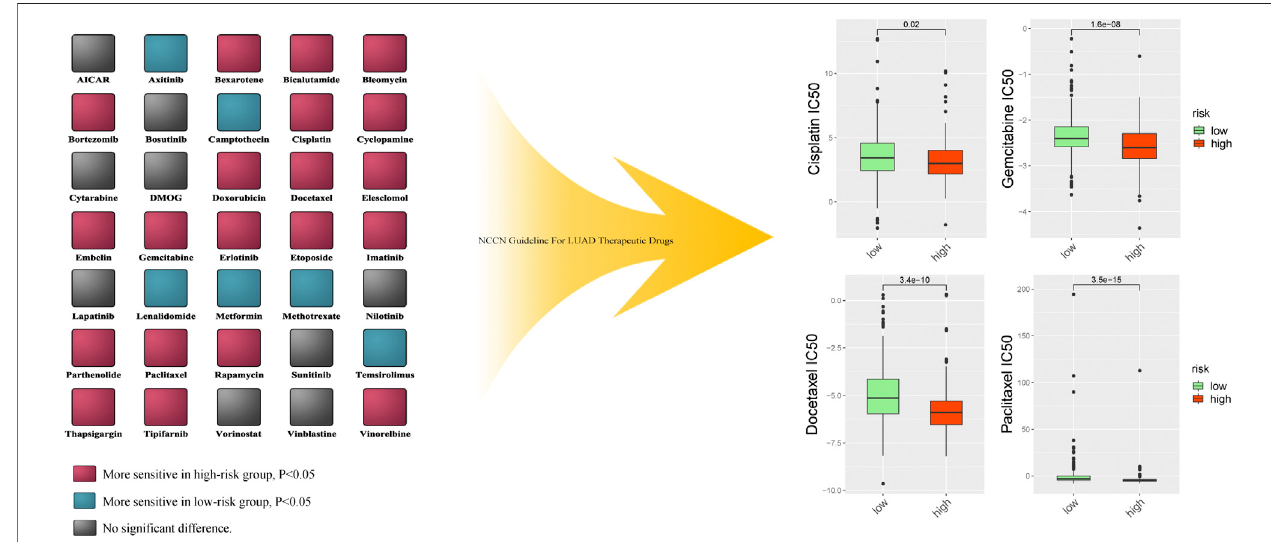
FIGURE 13 | The difference of multiple anti-cancer drugs sensitivity between high risk score group and low risk score group.